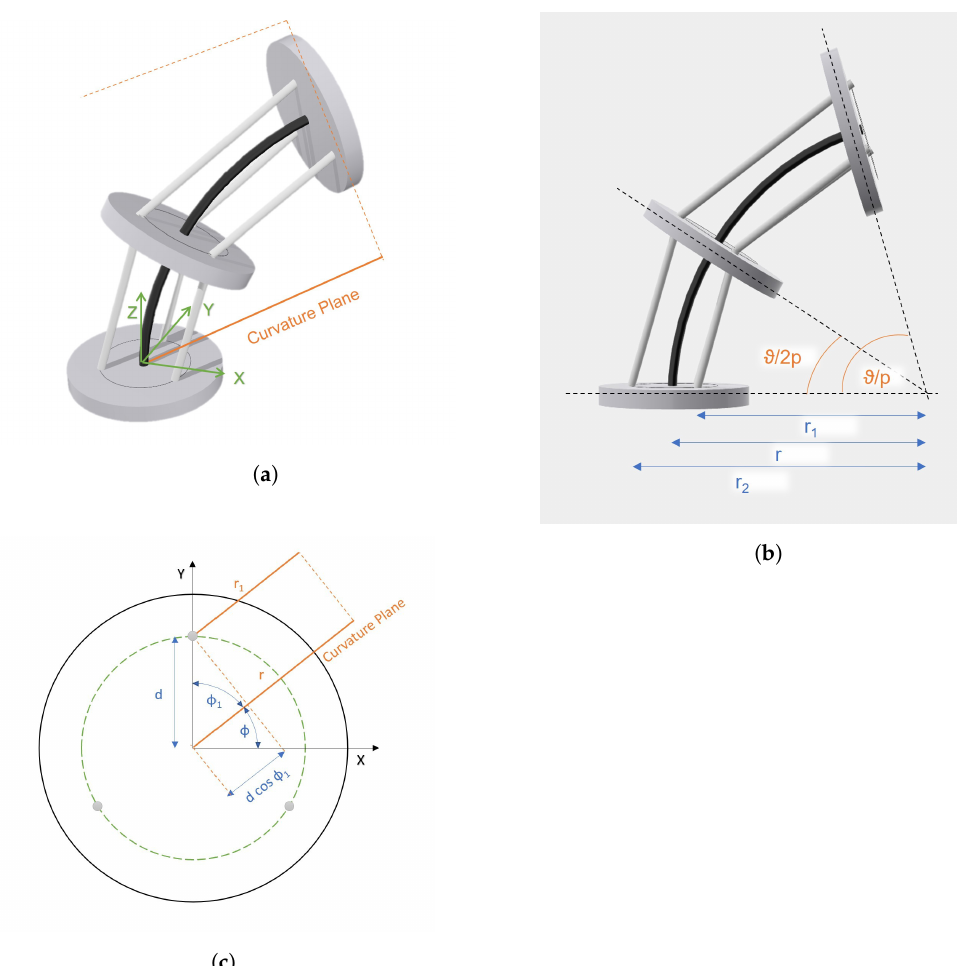
Figure 11. Auxiliary figures for the cables’ kinematic relationships. ( a ) Three-dimensional image of the proposed robot. ( d ) Geometric hypothesis to obtain the kinematic equations for the cables. ( c ) Bird’s-eye view of the robot’s section, including the curvature plane